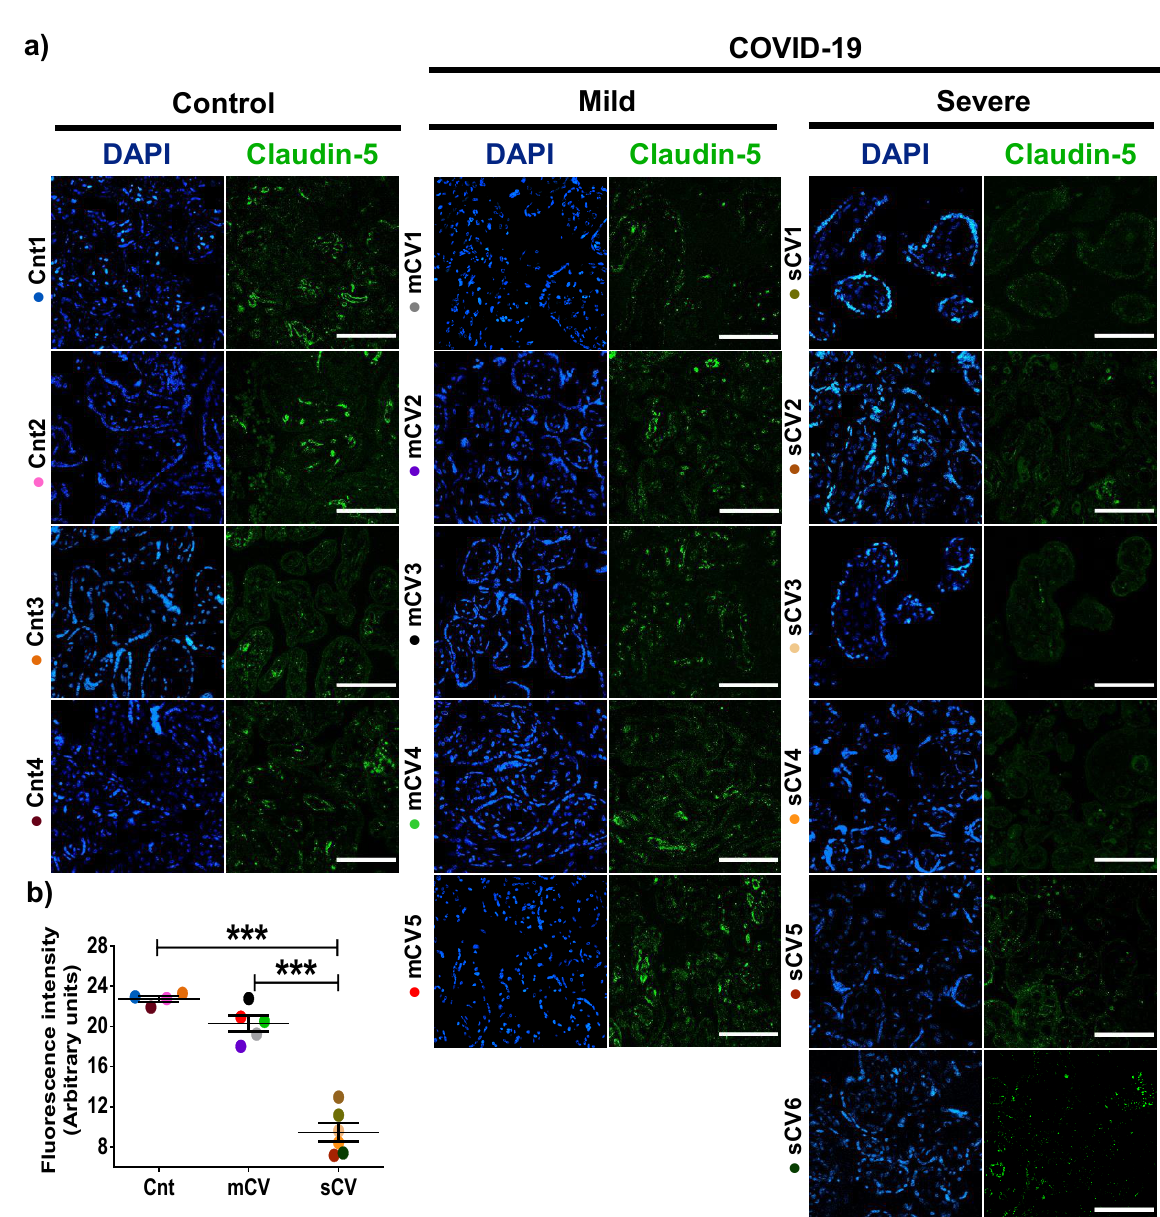
Figure 4. Claudin-5 expression diminishes in the endothelium of chorionic villi of placentas from women with severe COVID-19. Paraffin blocks of placentas derived from women with COVID-19 and controls were cut in 1 µm slices, deparaffinized, and processed for immunofluorescence with antibodies against claudin-5. ( a ) Representative images of claudin-5 in chorionic villi. DNA of nuclei was stained with DAPI. Bar, 100 μm. ( b ) Quantification of mean fluorescent intensity done on three independent images from each condition. Data are expressed as mean ± SD; One way ANOVA F test followed by the multiple comparison tests of Bonferroni and Dunnett, *** p < 0.001. Cnt, control; mCV, mild COVID-19; sCV, severe COVID-19.